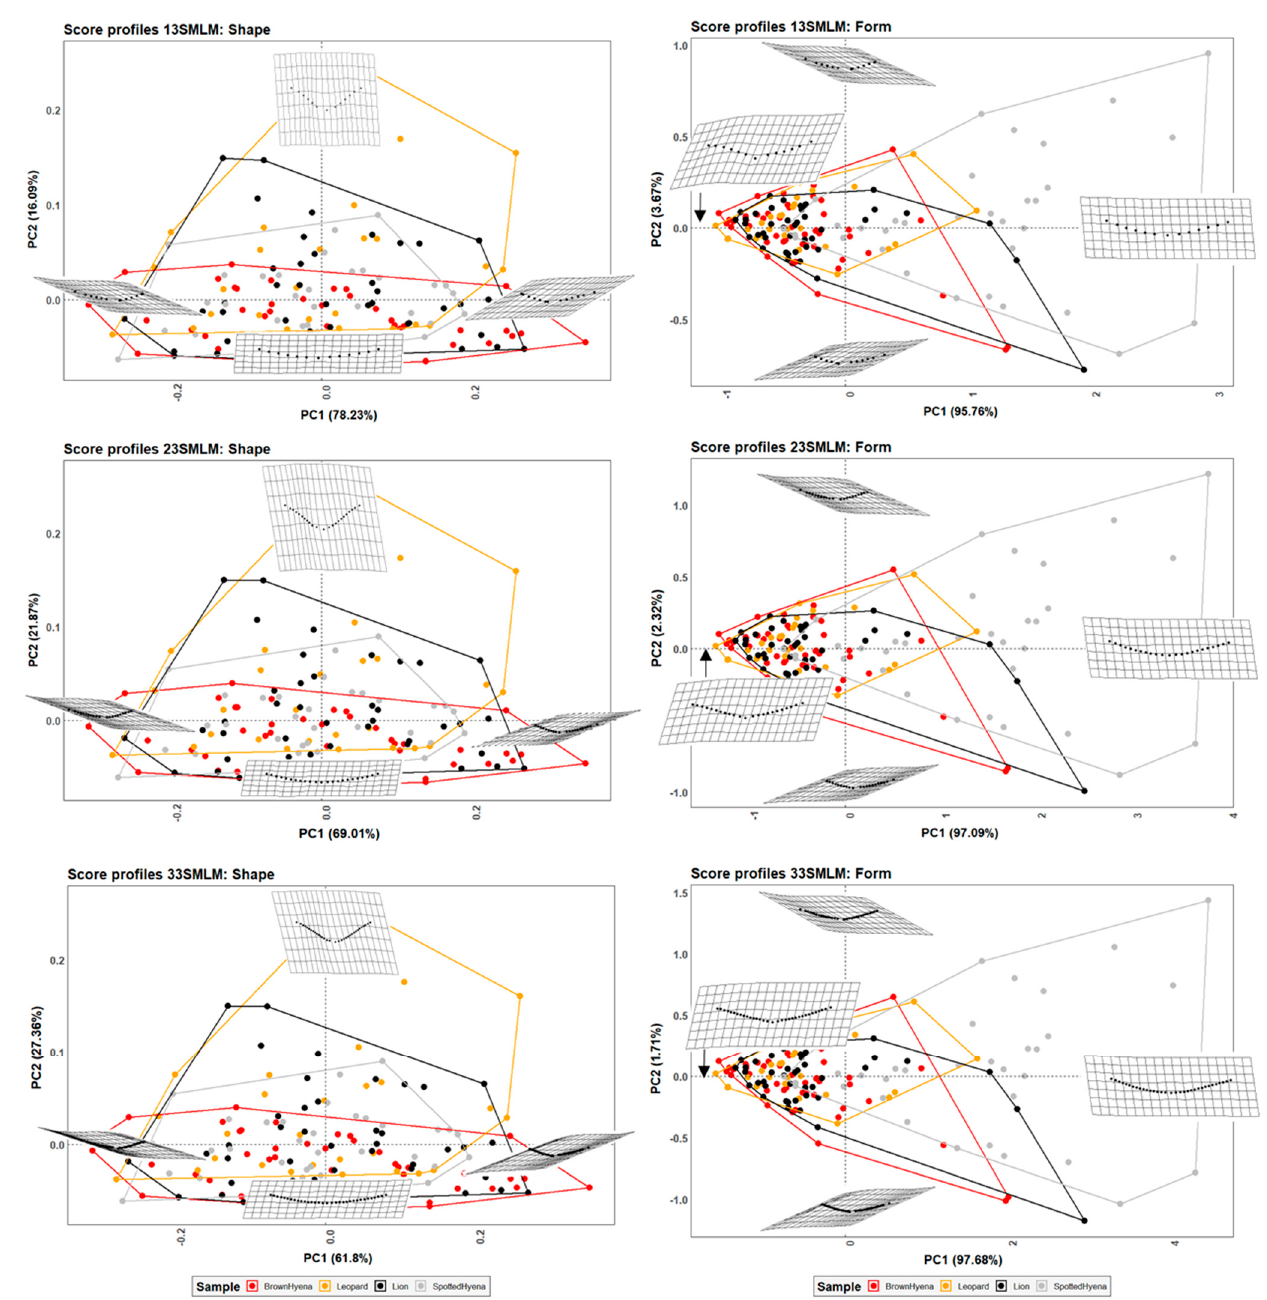
Figure 6. PCA plots in shape and form space on the 2-curves semilandmark models at the most conspicuous U score section, made by 13 points; 23 points; and 33 points. Extreme changes in shape and form along PC1 and PC2 are illustrated with the aid of transformation grids.